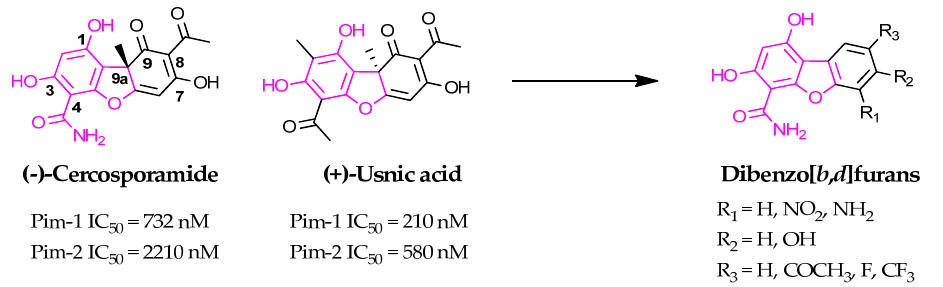
Figure 1. Drug design of the 1,3-dihydroxydibenzo[ b , d ]furan-4-carboxamide scaffold-based deriva- tives.